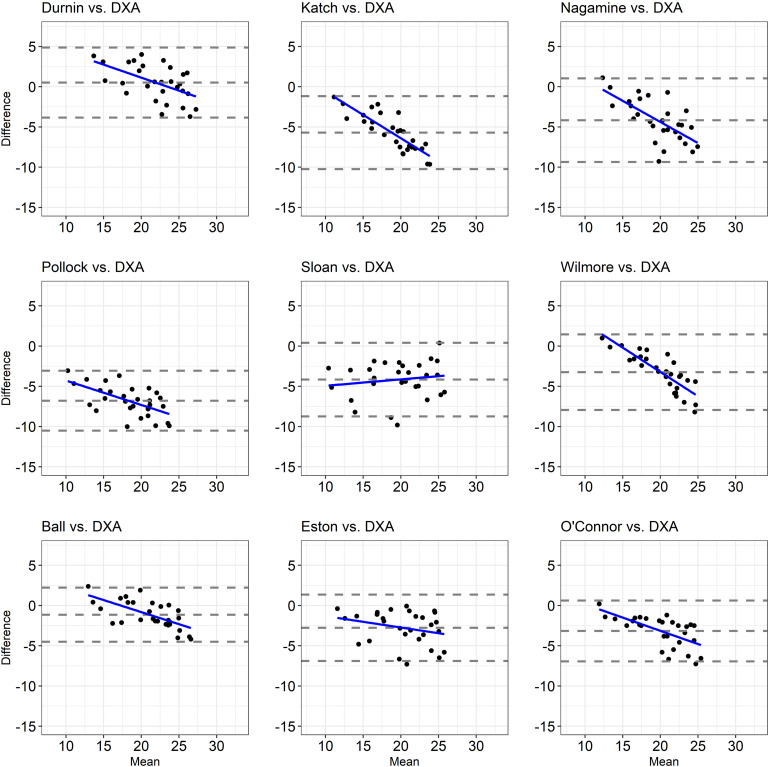
Bland-Altman Plots showing the agreement between the %FM assessed through anthropometric equations validated upon able-bodied non-athletic populations and the %FMDXA. The dashed lines indicate bias ± 2 standard deviations and the solid blue line indicates the regression line.